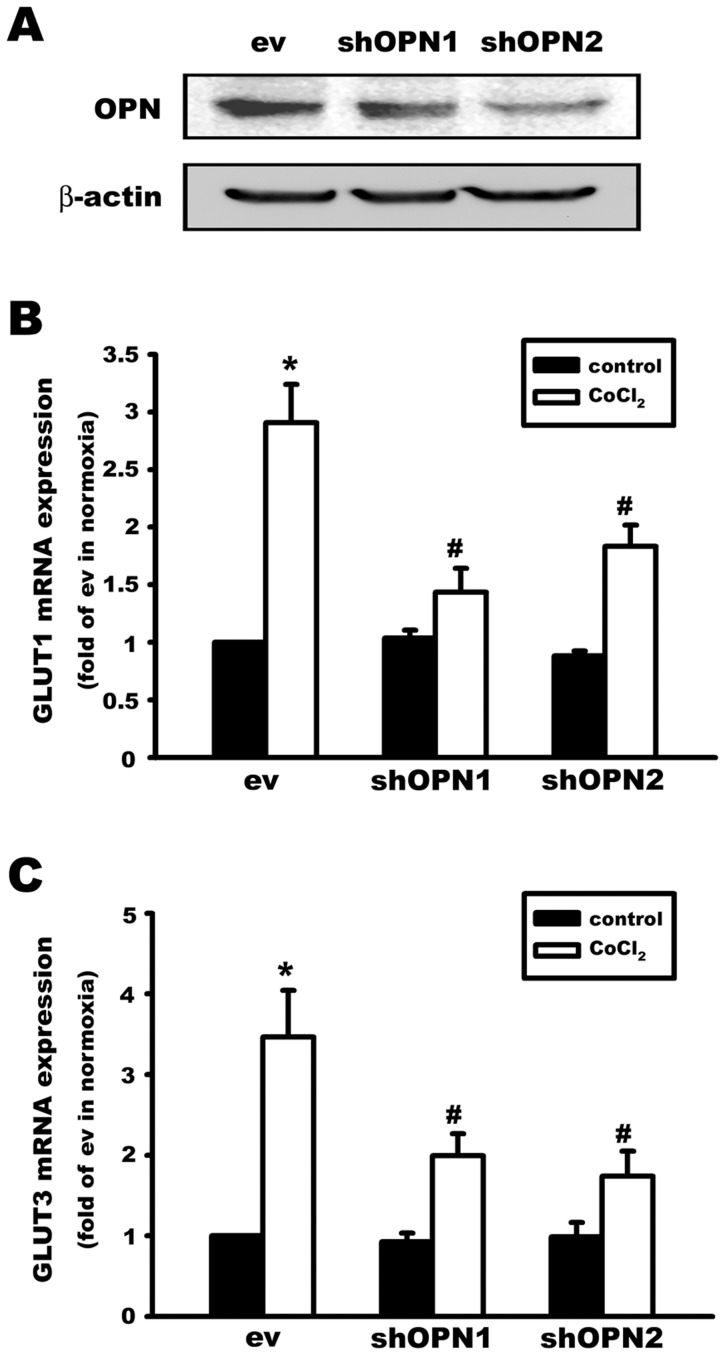
Knockdown of osteopontin decreases glucose transporters expression in a hypoxic osteosarcoma cell line.(A) Two OPN-shRNA plasmids (shOPN1 and shOPN2) and one empty vector (ev) plasmid were transiently transfected (24 h) in MG63 cells. OPN protein expression was downregulated by both shOPN1 and shOPN2. After treatment with the chemical hypoxia agent CoCl2 (100 µM, 6 h), GLUT1 (B) and GLUT3 (C) mRNA expression was markedly upregulated in the empty vector (ev) group. This effect was significantly antagonized by OPN knockdown (shOPN1 and shOPN2) in MG63 cells. Data are presented as the mean ± S.E.M. (n = 4), *p≤0.05, compared with the empty vector group (ev) in the control group, #p≤0.05, compared with the empty vector group (ev) in the CoCl2 treatment group.